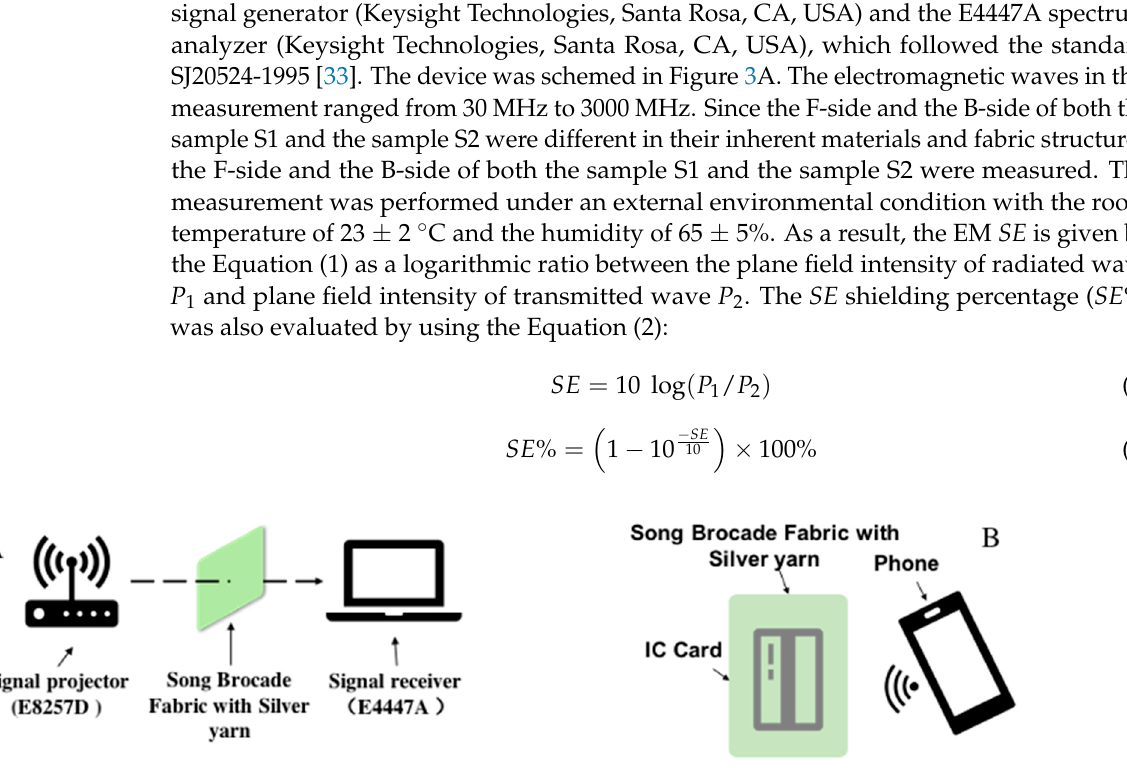
Figure 3. Evaluation of NFC shielding for the prepared samples (( A ): The standard measurement and ( B ): the measurement with mobile phone and IC card).